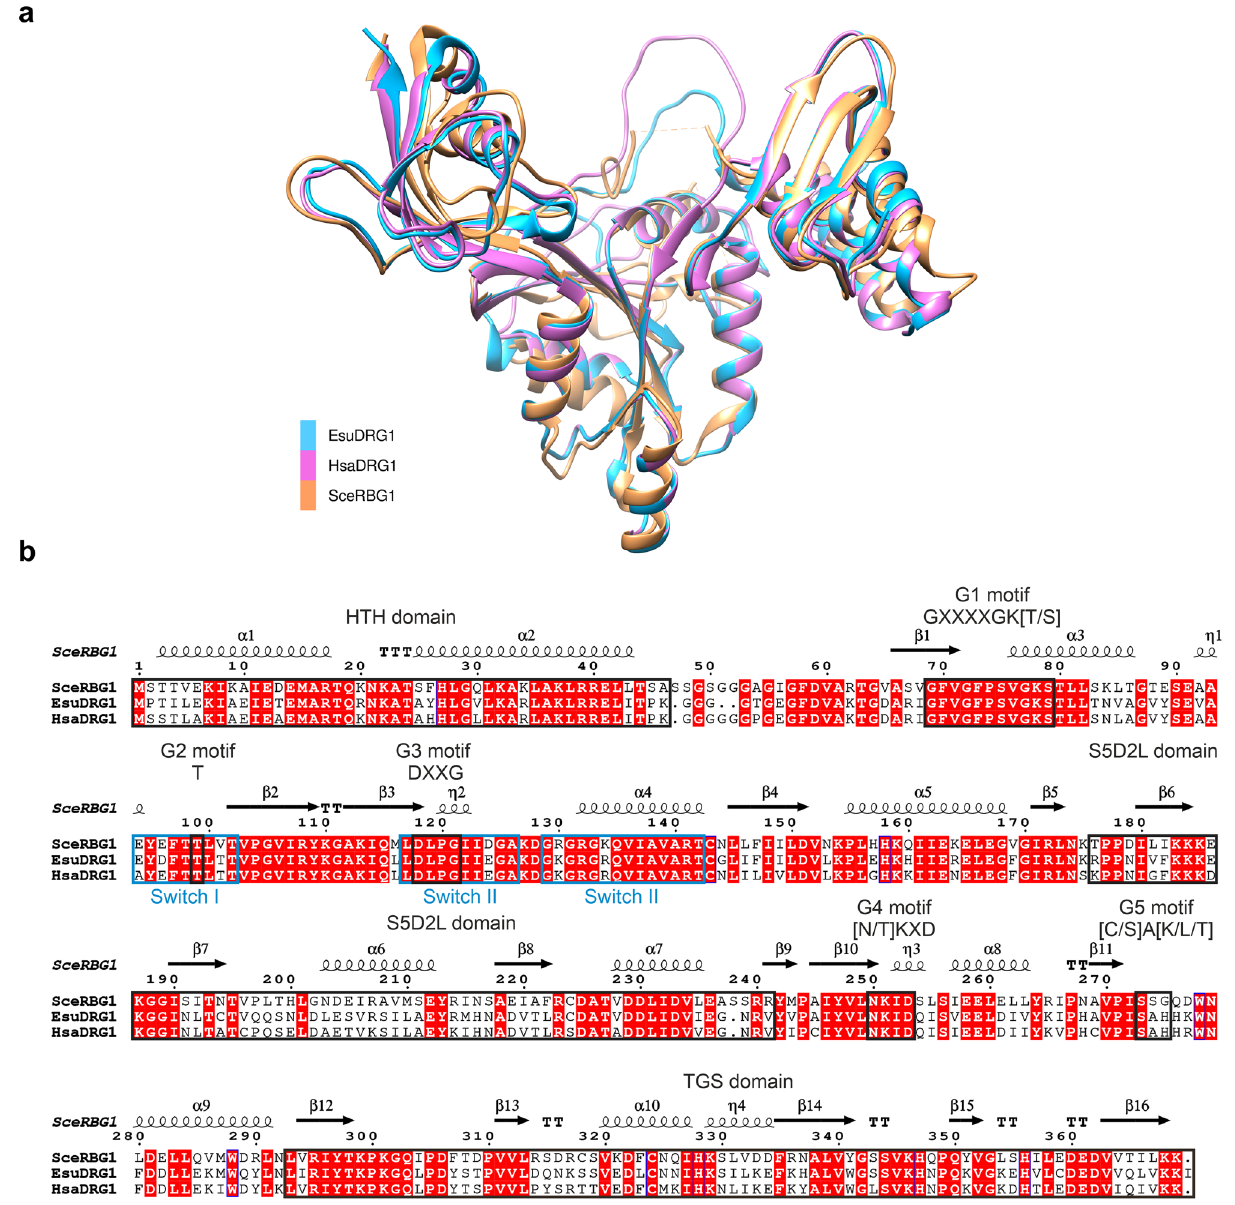
Saccharomyces cerevisiae (PDB:4A9A) (orange). ( b ) Sequence alignment of DRG1 from Eunapius subterraneus, Homo sapiens and Saccharomyces cerevisiae . Regions of DRG1 proteins in boxes are indicated above the alignment, from N-terminus; HTH domain, G1 motif, G2 motif, G3 motif, S5D2L domain, G4 motif, G5 motif and TGS domain. The amino acid sequences of DRG1 were aligned using the Clustal Omega (https:// www. ebi. ac. uk/ Tools/ msa/ clust alo/); the secondary structures are predicted using the ESPript (http:// espri pt. ibcp. fr/ ESPri pt/ ESPri pt/ index. php). Red boxes with white letters indicate a strict